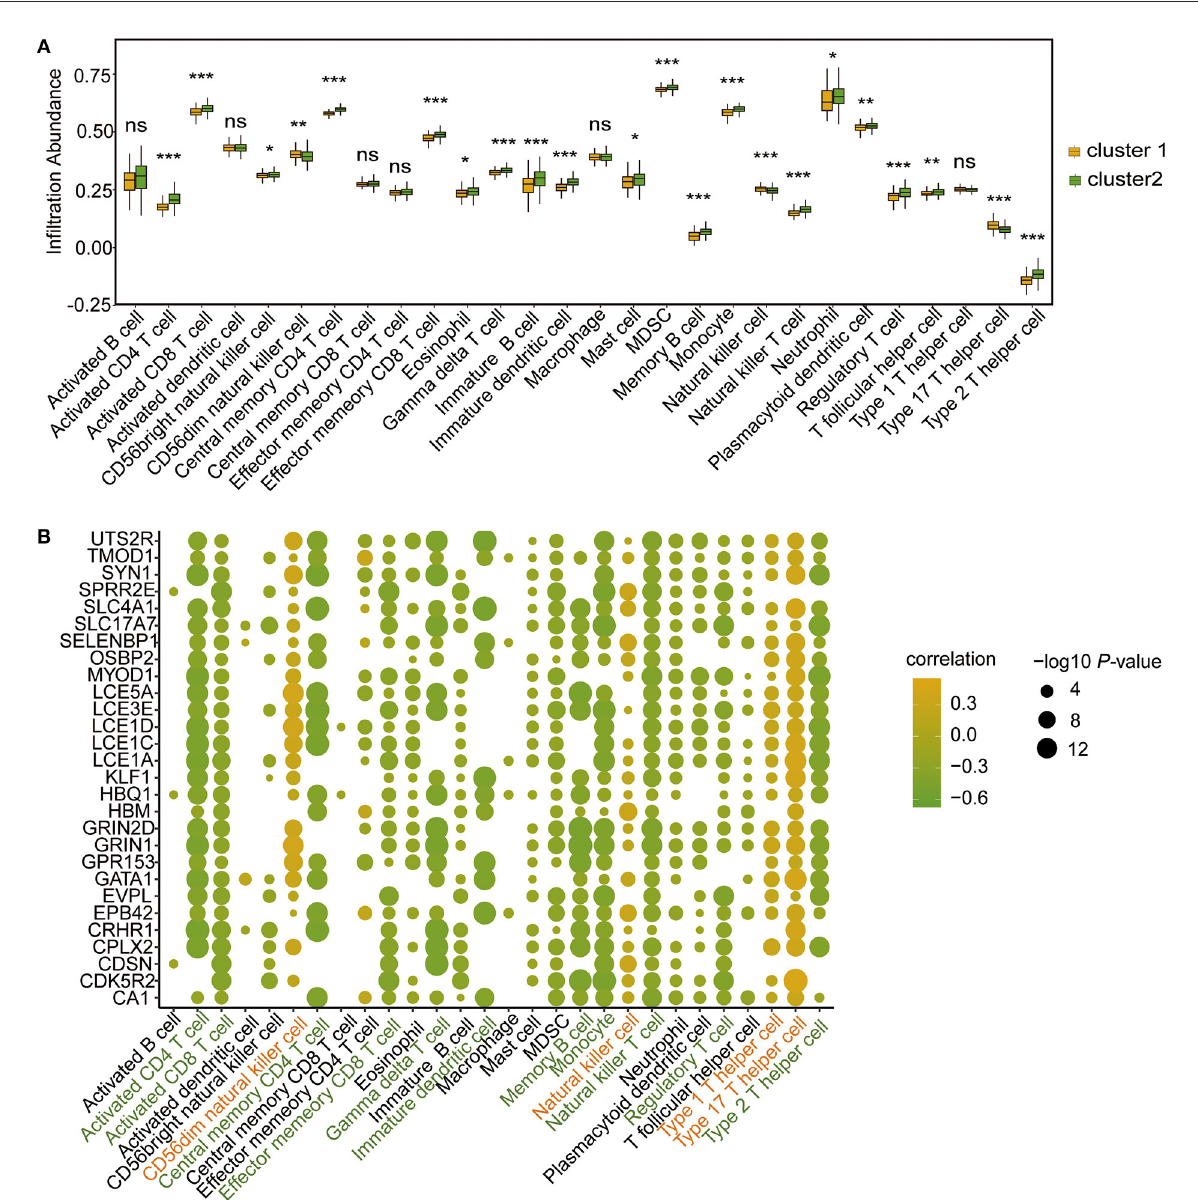
FIGURE8 Immune microenvironment characteristics of immune cells in CHD patients of the two m6A RNA modification patterns according to ssGSEA. (A) Box plot showing the immune cell levels in the two m6A RNA modification patterns based on ssGSEA result. The statistical significance was calculated via Wilcoxon rank sum test, *** P < 0.001, ** P < 0.01, * P < 0.05. (B) The correlation between hub-genes and immune cell levels. The horizontal axis represents immune cells, the vertical axis represents Hub gene, the node color represents correlation, and the node size represents significance